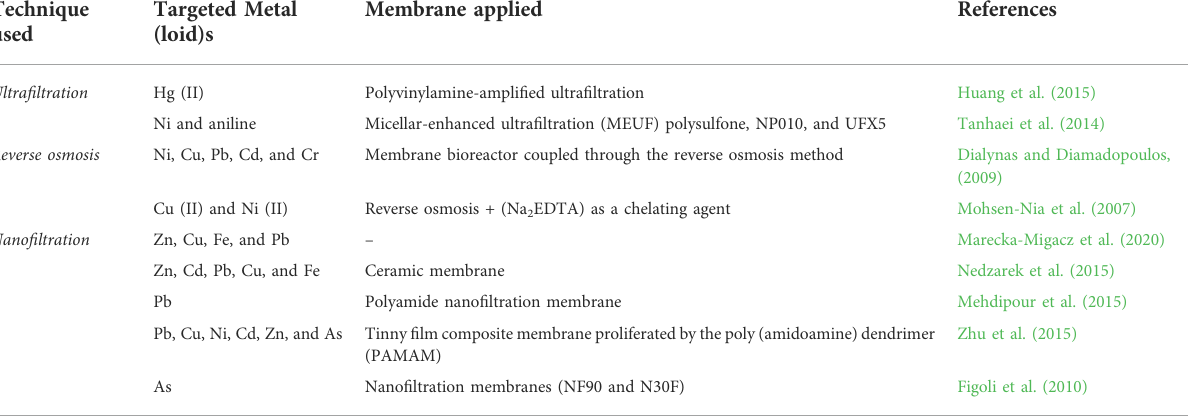
TABLE 5 Different membranes applied in the membrane fi ltration technique for the removal of metal (loid)s. Technique